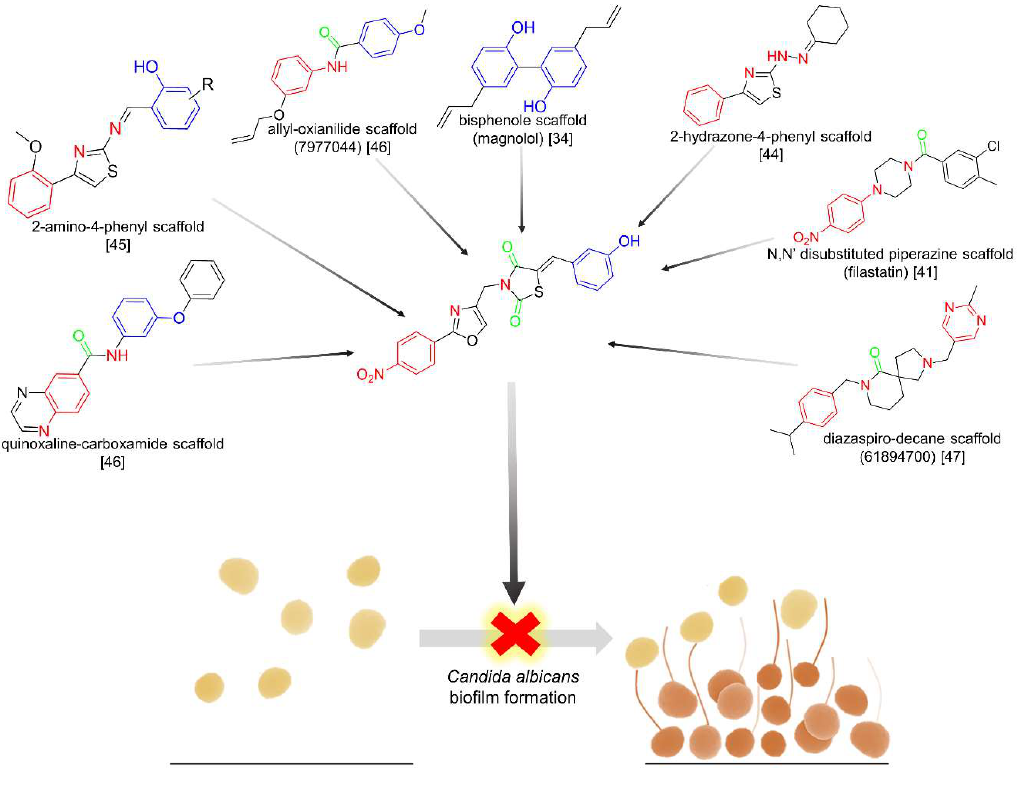
Figure 1. The new N -(oxazolylmethyl)-thiazolidinedione scaffold, encompassing various structural moieties present in known anti- biofilm agents.